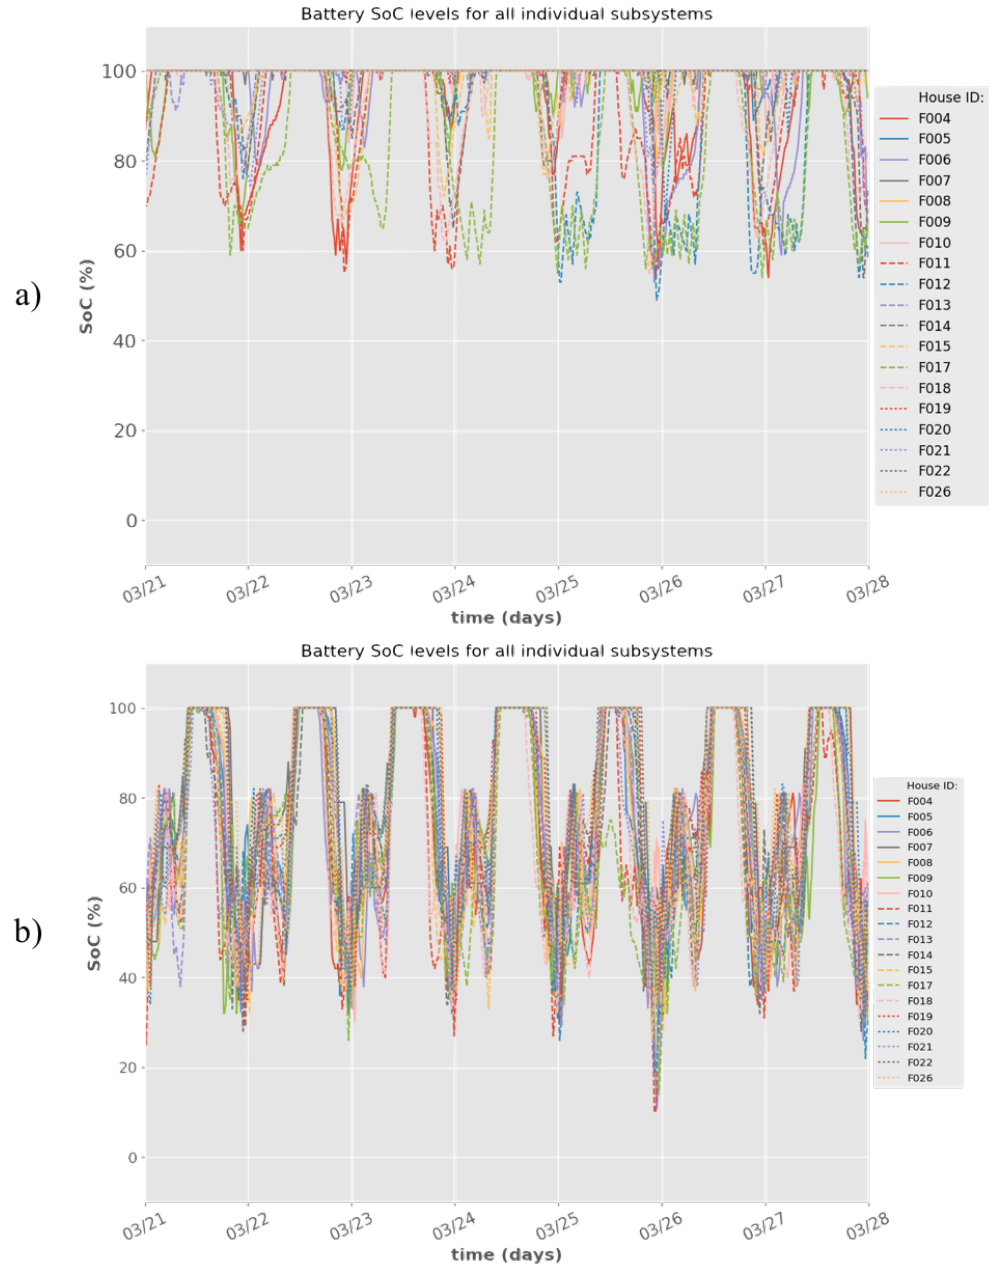
Figure 9. Battery SoC level of all standalone systems in the cases of using ( a ) priority-based internal without fuel cell scheduling function and ( b ) priority-based internal with added scheduling